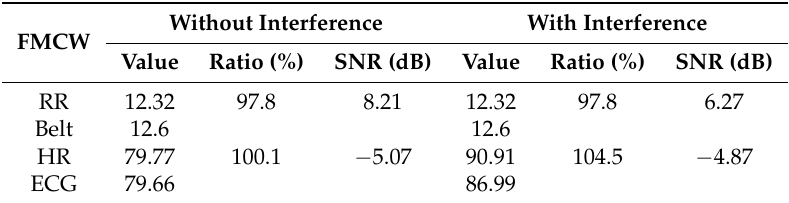
Figure 14. Interference results of FMCW; ( a ) slow time plot of noise at fast time index 500, ( b ) histogram of noise. Table 11. Anti-interference results of FMCW radar.